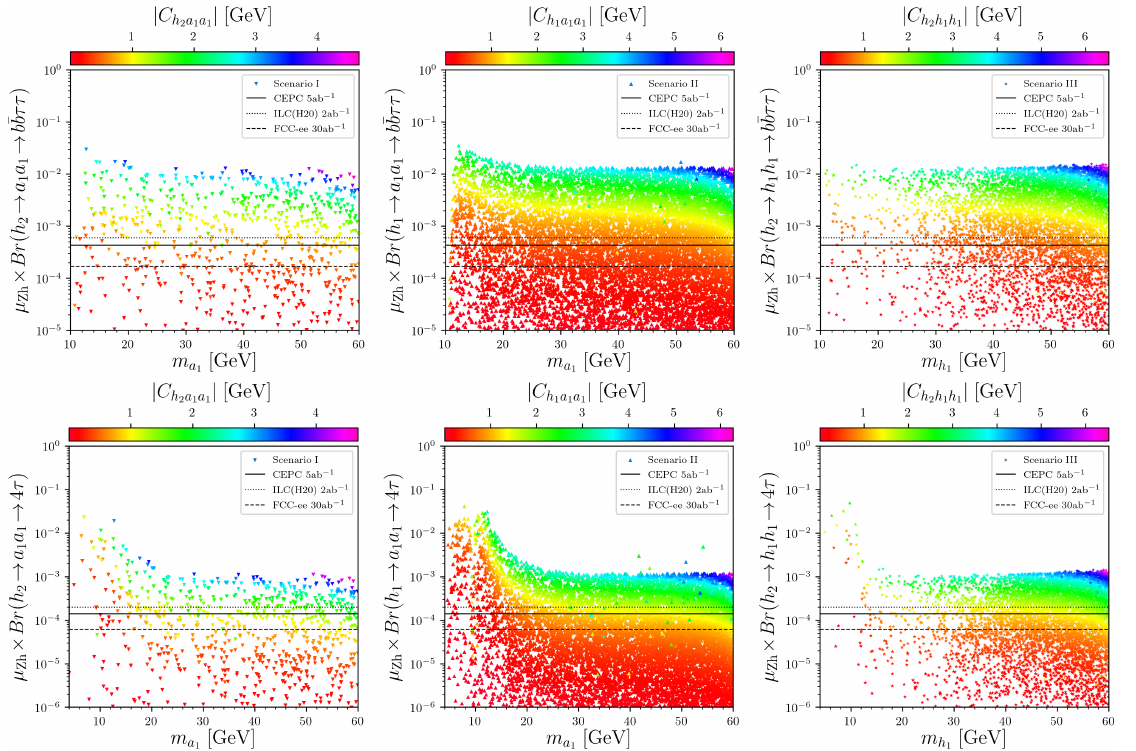
Figure 14. Allowed rates for various Higgs–Strahlung processes with successive decays into two light scalars. Top : 2 b 2 τ final state. Bottom : 4 τ final state. Expected upper bounds for various collider machines are also shown, with projections from [42]. Figure taken from